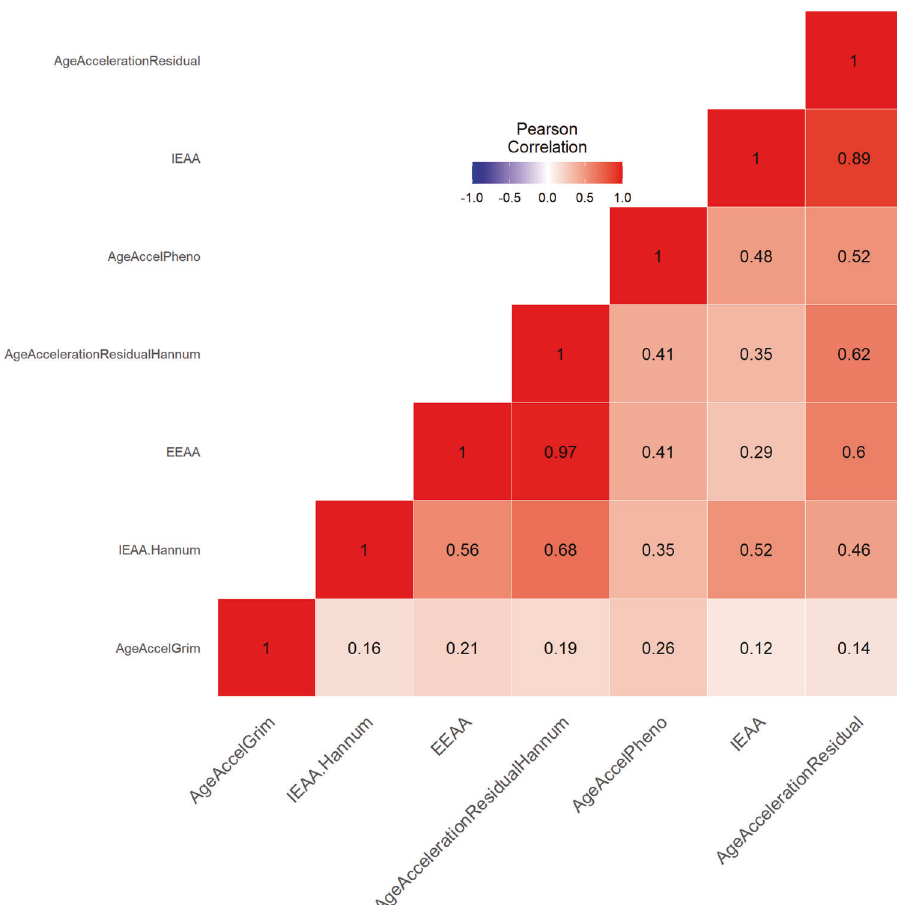
Fig. 2 Correlations of AgeAccelGrim with other epigenetic age clocks. The plot visualizes the inter-correlations between seven DNAm clocks. The deeper color indicates stronger correlations. AgeAccelGrim was relatively independent to other clocks, while AgeAccelPheno was correlated of medium strength with the acceleration of Horvath and Hannum